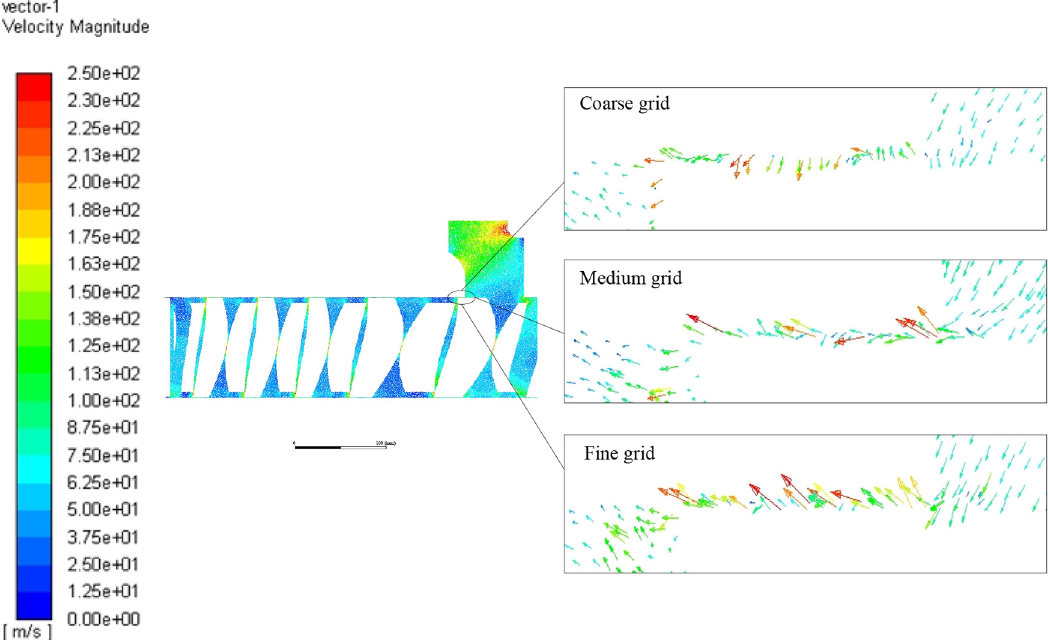
Fig. 10. The fl ow velocity vector diagram of the three